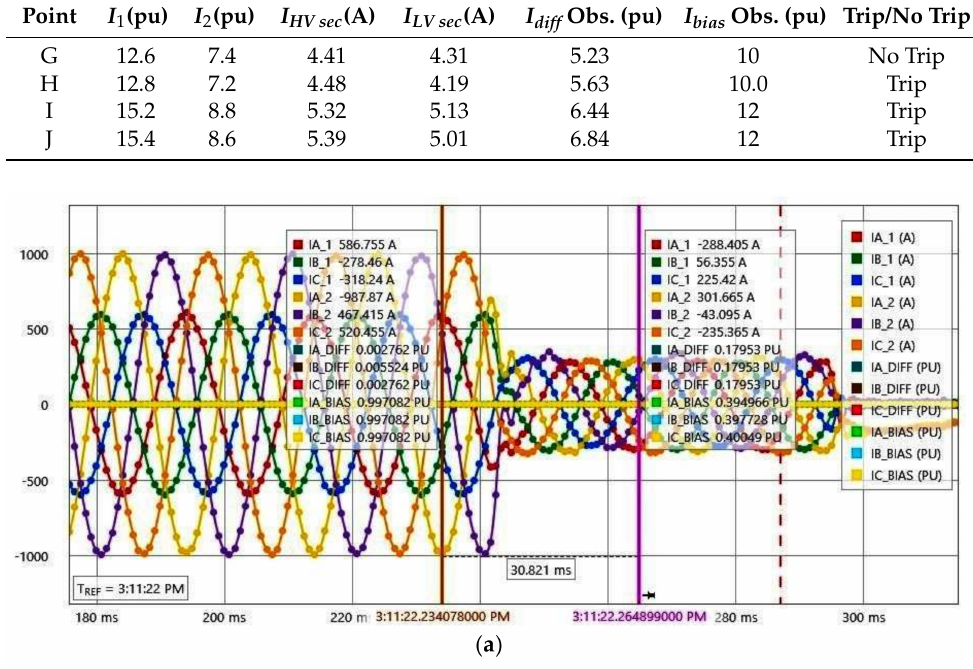
Table 12. Test results of bias characteristics for points selected in accordance with setting ‘ I S − H S 1 ’ and ‘ I S − H S 2 ’ in Figure 11a.